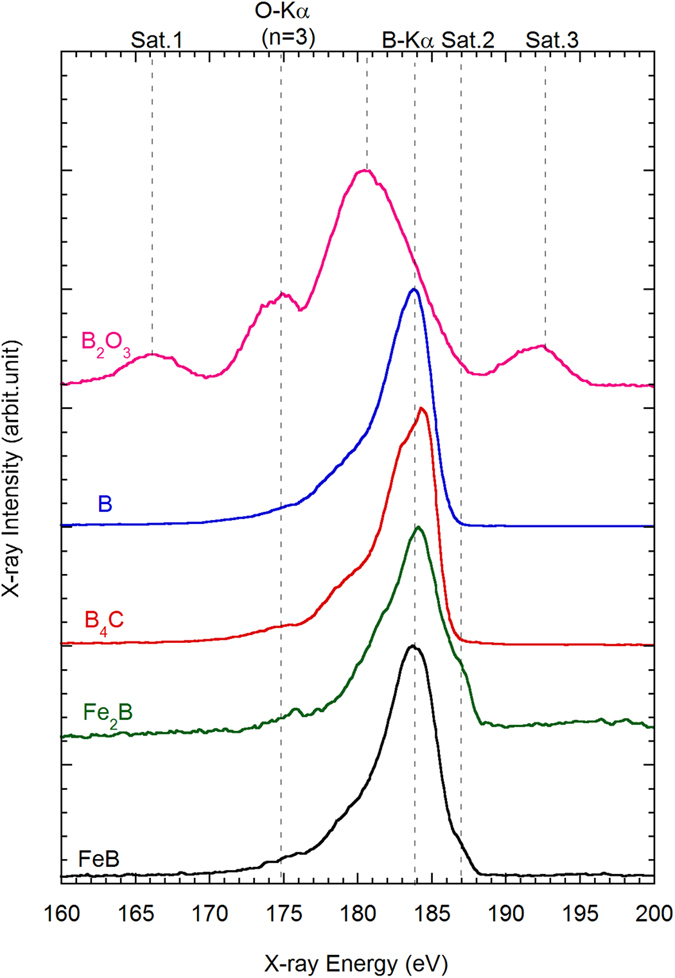
Soft X-ray emission spectra from B2O3, B, B4C, Fe2B, and FeB, obtained by EPMA-SXES.